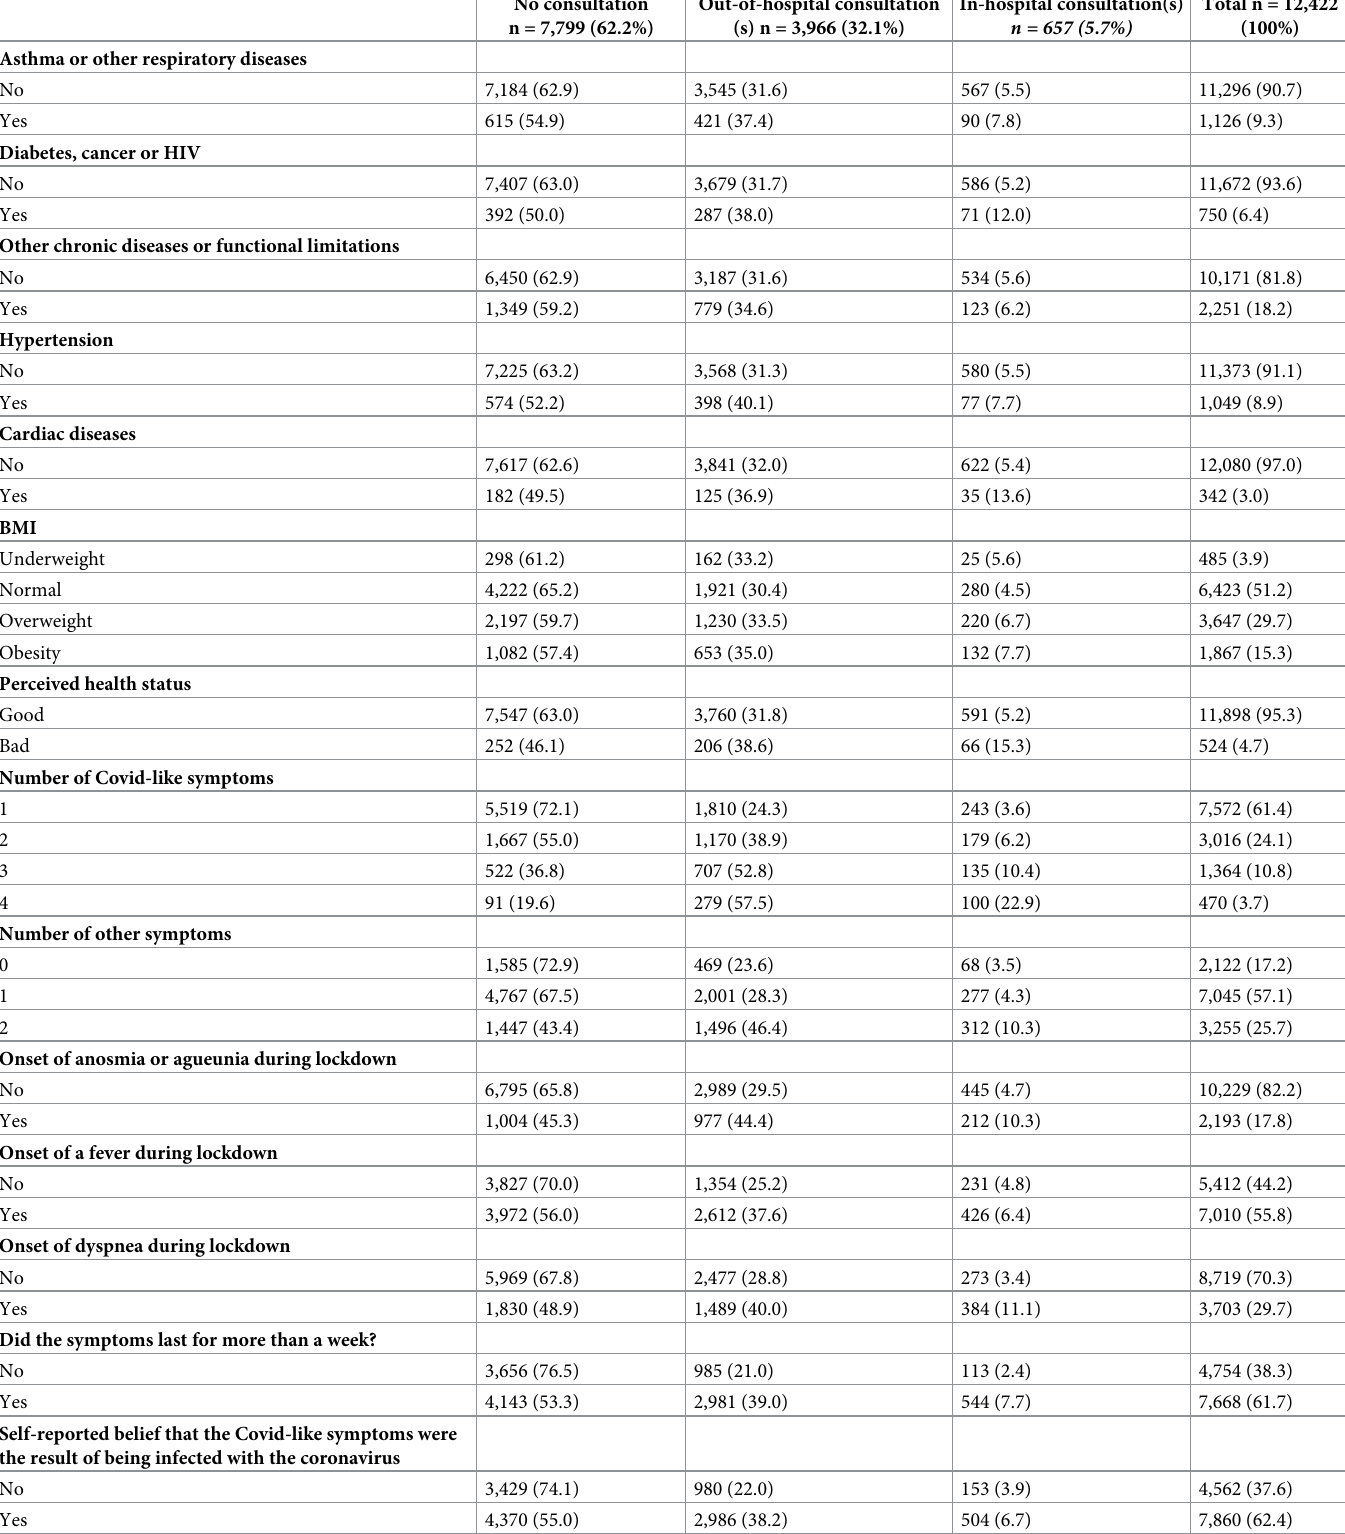
Table 2. Distribution of the use of health care services by health